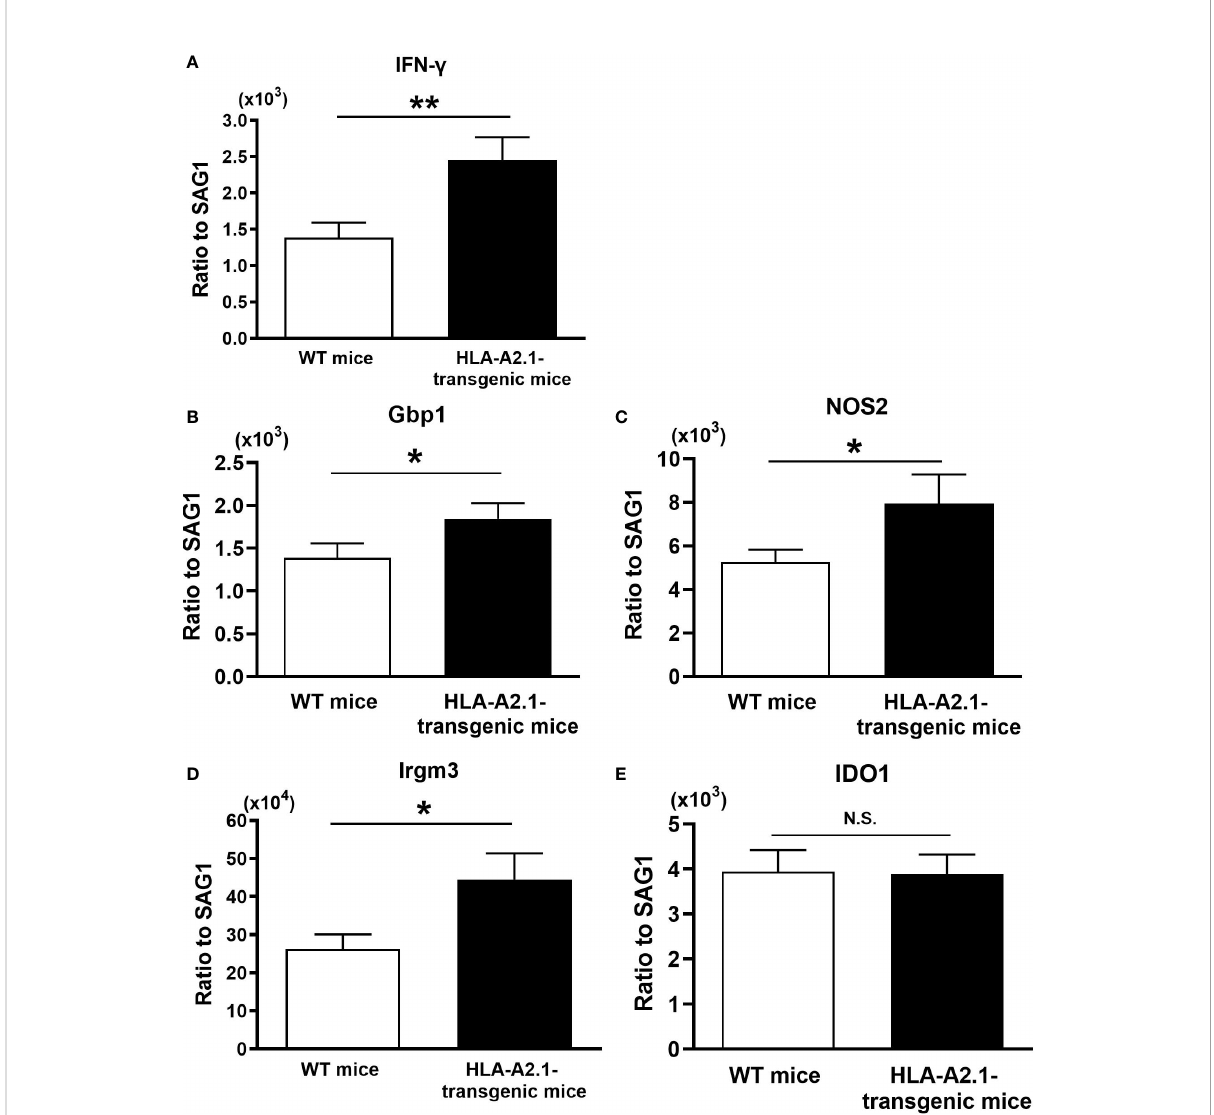
FIGURE 3 The ef fi ciency of expressions of IFN- g and effector molecules for the IFN- g -mediated protective immunity against tachyzoites are higher in the brains of the HLA-A2.1-transgenic than those of WT control mice during reactivation of cerebral infection with T. gondii . The HLA-A2.1- transgenic and WT control mice were infected with 10 cysts of the ME49 strain and treated with sulfadiazine beginning at 7 days after infection for 10 days to control tachyzoite proliferation during the acute stage of infection and establish chronic infection in their brains. Four to fi ve weeks after the discontinuation of sulfadiazine, which induces reactivation of the cerebral infection, the ef fi ciency of the expression of mRNA for (A) IFN- g , (B – E) the effector molecules (Gbp1, NOS2,Irgm3, and IDO1) in the IFN- g -mediated protective immunity in response to tachyzoites (the ratios of mRNA levels for IFN- g and the effector molecules against mRNA levels for tachyzoite-speci fi c SAG1) were measured by real-time RT-PCR on the brains. * P <0.05, ** P <0.01. N.S. Not signi fi cant. The data were combined from three independent experiments (n= 10 or 11 for the HLA-transgenic mice, and n=14 for the WT control